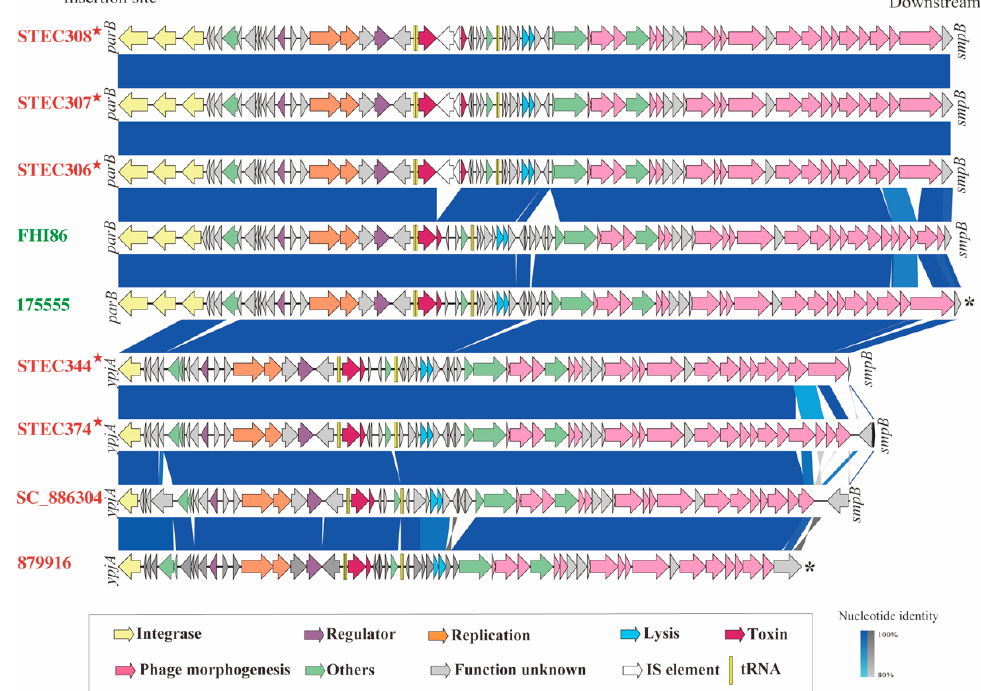
Figure 2. Comparison of the nine Stx2l ‐ converting prophages. The arrows indicate gene directions. The coding sequences are represented by arrows and linked by blue bars shaded to represent the nucleotide identity and gray bars shaded to represent the nucleotide identity of reverse complemented homologous sequences, as indicated in the legend. The color of the text indicates the source of the strains; red represents food ‐ derived Stx2l ‐ STEC strains, and green represents human ‐ derived Stx2l ‐ STEC strains. The red stars indicate strains in this study. The insertion sites and downstream of prophages in the chromosomes are shown at the start and end of the prophages. The asterisk (*) signifies that downstream of the phage could not be conclusively identified.